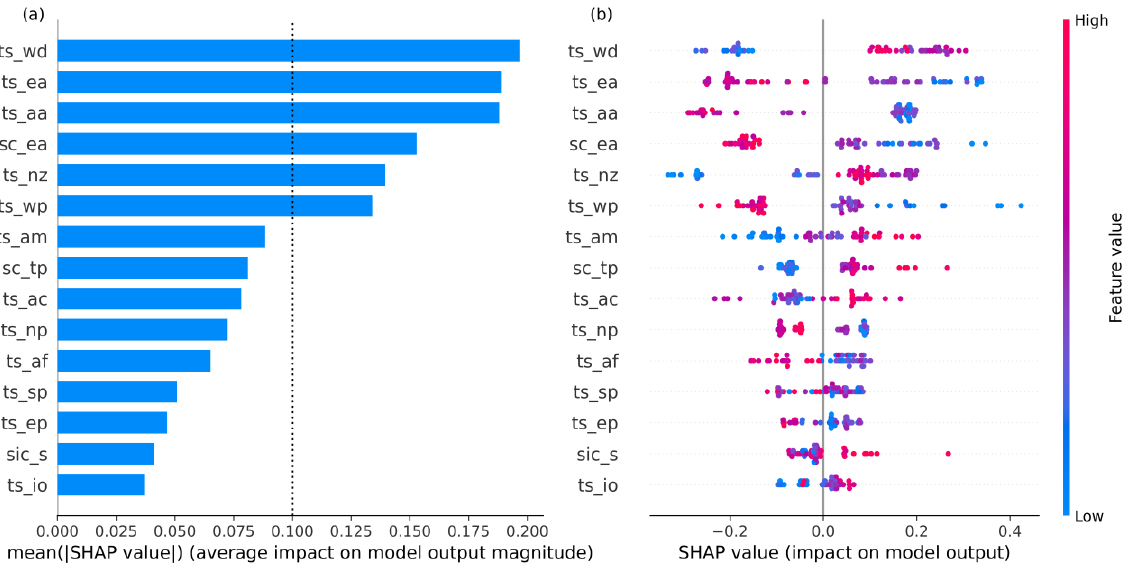
Figure 4. The global ( a ) and local ( b ) feature importance in all samples. Each dot in ( b ) represents one sample, and the colors of the dots represent the values of the sample features (also known as feature values).